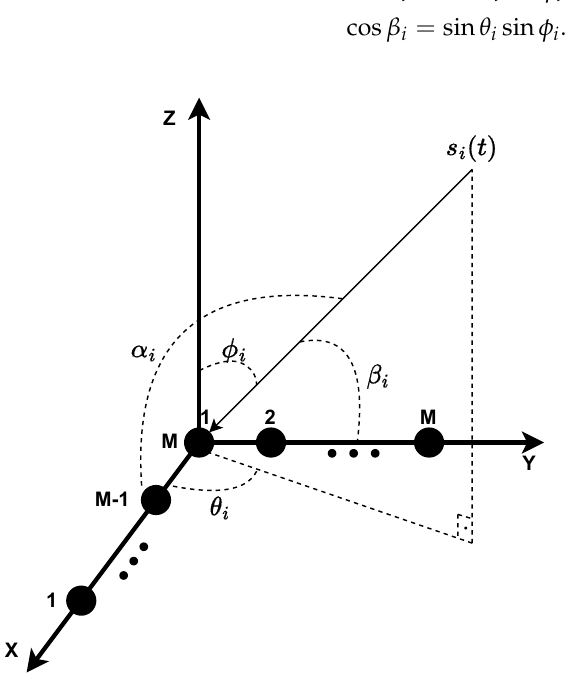
Figure 3. Depiction of L-shaped array with its antennas (black dots), angles, and the signal